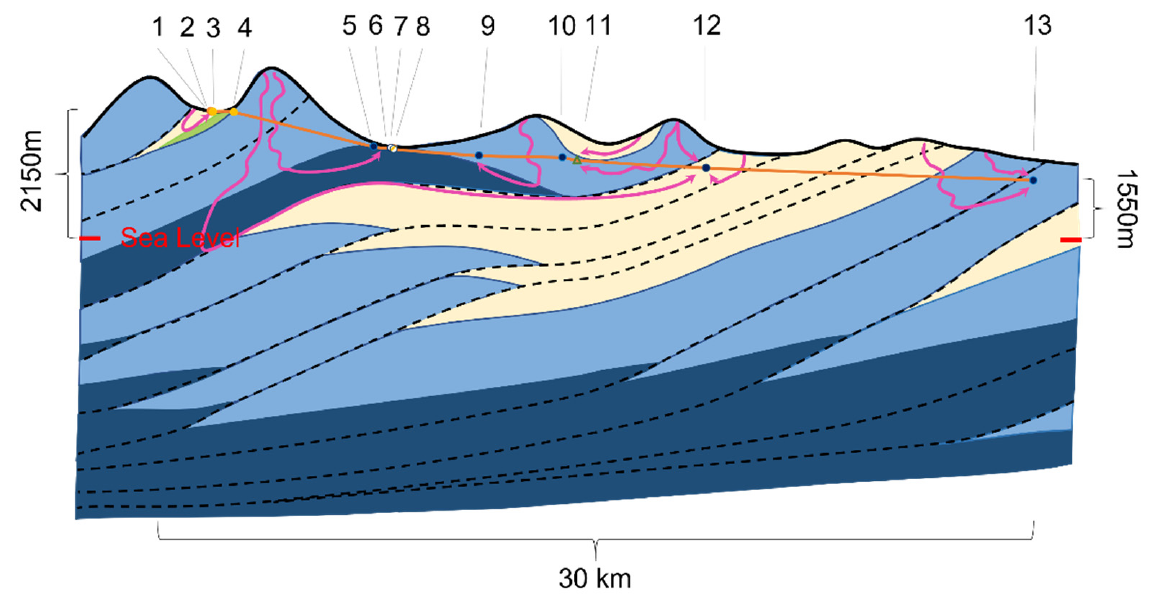
Figure 2. Schematic cross-section of the Upper Elbow Watershed (A-A (cid:48) on Figure 1) with Little Elbow River elevation profile projected (orange line). Numbers indicate the approximate location of sampling locations (yellow and blue dots (named in Table 1). Yellow units are the youngest (Mesozoic) siliciclastic rocks, green unit is Mezozoic interbedded siliciclastic and carbonate, medium blue units are younger (Upper Paleozoic) carbonates, dark blue are older (Lower Paleozoic) carbonates. Dashed lines indicate thrust faults and pink arrows illustrate some of the many possible conceptual local and intermediate flow pathways. Note the figure has significant vertical exaggeration. (Adapted from CSPG Field Guide [41]). Figures 1 and 2 emphasize the alternating siliciclastic and carbonate rock units through which the Little Elbow flows. Krouse and Mayer [42] demonstrated that paired δ 34 S SO4 Table 1. Ion and Isotope Data for Oct 26 Longitudinal Streamflow and Representative Summer Samples.